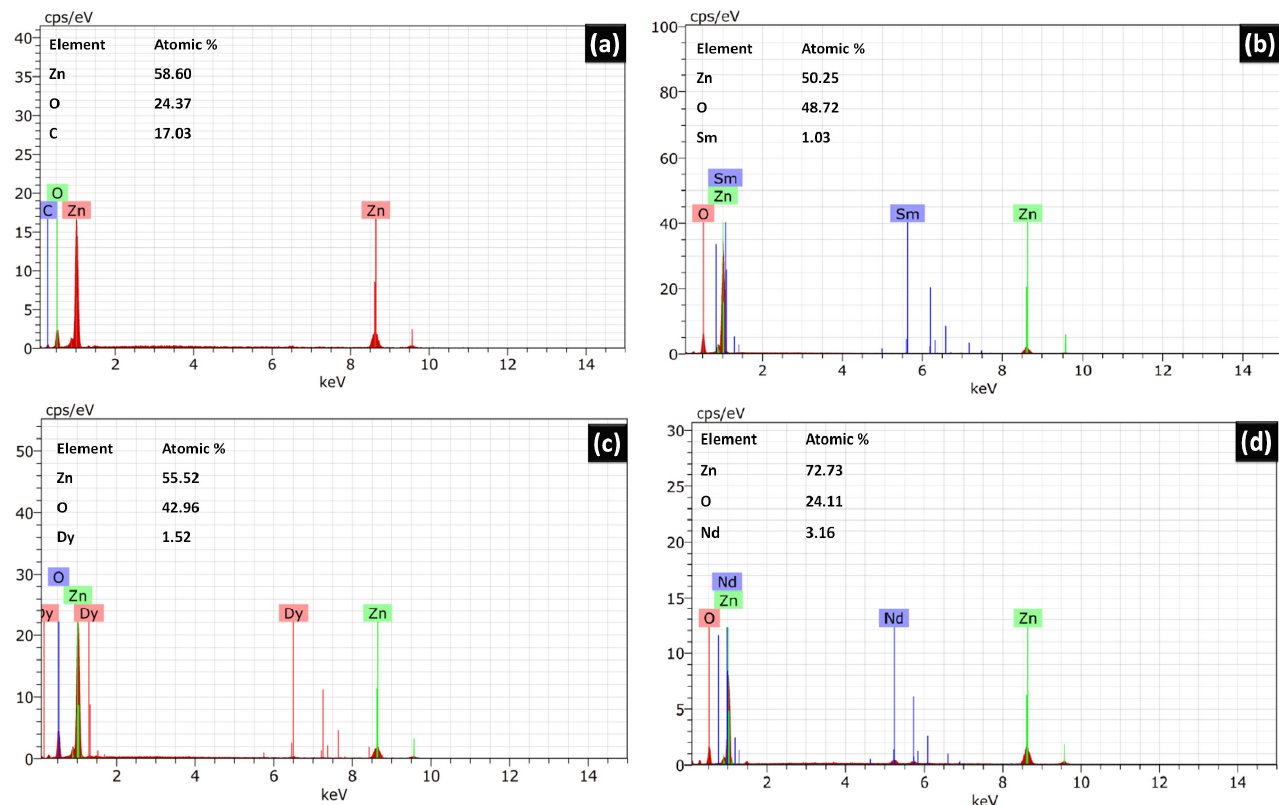
Figure 4. ( a – d ) Energy dispersive X ‐ ray spectrum for undoped ZnO, Sm doped ZnO, Dy doped ZnO, and Nd doped ZnO nanoparticles.